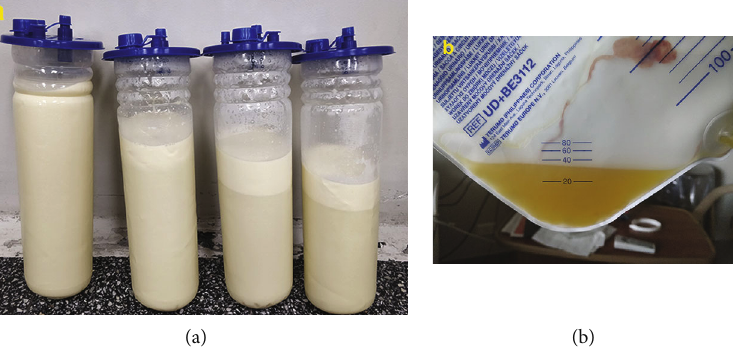
Figure 4: Evolution of the appearance of the abdominal drainage fl uid. Milky white ascites obtained during surgery can be seen in the suction receptacles (a). Since the fi rst postoperative day, clear liquid can be seen in the intra-abdominal drainage collecting bag